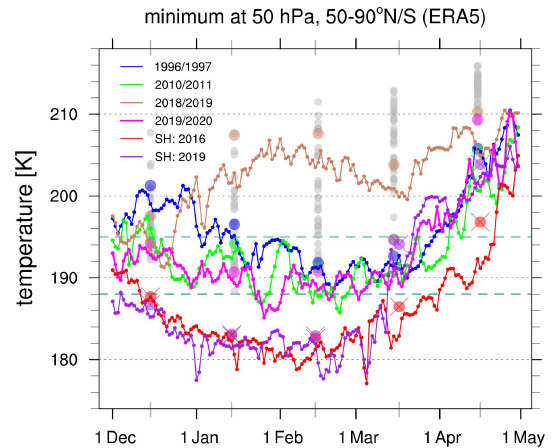
Figure 6. Minimum values of daily (lines) and of monthly (dots; in the center of each month) mean temperatures (in K) at 50hPa (about 20km altitude): the Northern Hemisphere winters 1996/1997, 2010/2011, 2018/2019, and 2019/2020 for 50–90 ◦ N from 1 De- cember to 30 April based on ERA5 data are displayed by blue, green, brown, and magenta (lines and dots); the Southern Hemi- sphere winters 2016 and 2019 for 50–90 ◦ N from 1 June to 1 November based on ERA5 data are displayed in red and pur- ple (lines and dots with crosses). The Southern Hemisphere data are shifted by 6 months. Additionally, the minima of the monthly mean temperature data for the Northern Hemisphere winters from 1979/1980 to 2019/2020 are shown as grey dots in the center of each month. For simplicity, the leap day in 2020 (29 February) was neglected in the daily time series. The dashed dark green horizon- tal lines at 195 and 188K mark the thresholds for the formation of NAT-PSCs and ice PSCs, respectively (see text).